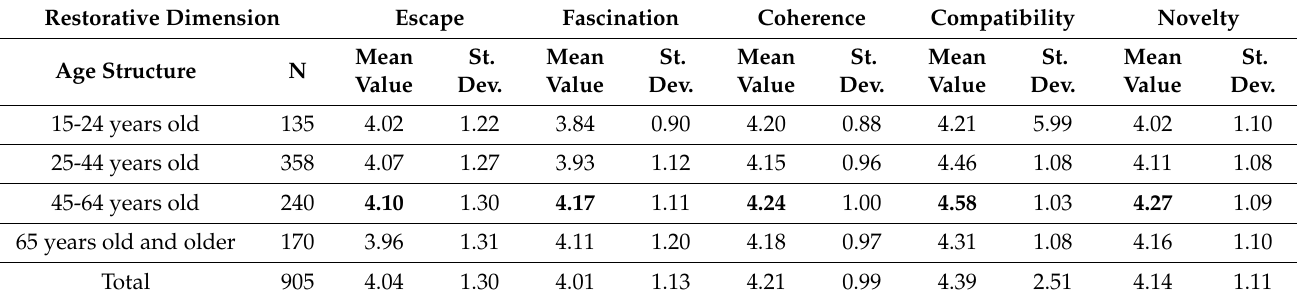
Table 6. Relationship between age structure and restorative dimensions, using the “Oneway Anova”. Restorative Dimension Escape Fascination Coherence Compatibility Novelty Mean Age Structure N